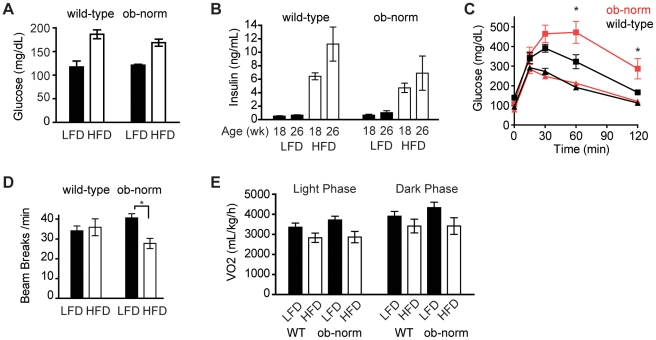
Glucose metabolism and energy expenditure.
A. Plasma glucose concentrations in ad libitum fed wild-type and ob-norm mice that were maintained on a high-fat diet (open bars) or low-fat diet (filled bars). B. Plasma insulin concentrations of wild-type and ob-norm mice at 18 and 26 weeks of age that were maintained on a high-fat diet (open bars) or low-fat diet (filled bars). C. Plasma glucose concentrations in response to a glucose injection in wild-type (black) and ob-norm (red) mice. Triangles represent mice on a low-fat diet and squares represent mice on a high-fat diet. * indicates p<0.05. D. Average beam breaks per minute for wild-type and ob-norm mice maintained on a low-fat (filled bar) or high-fat (open bar) diet. E. Average oxygen consumption for wild-type and ob-norm mice in the light phase (open bars) and dark phase (closed bars).